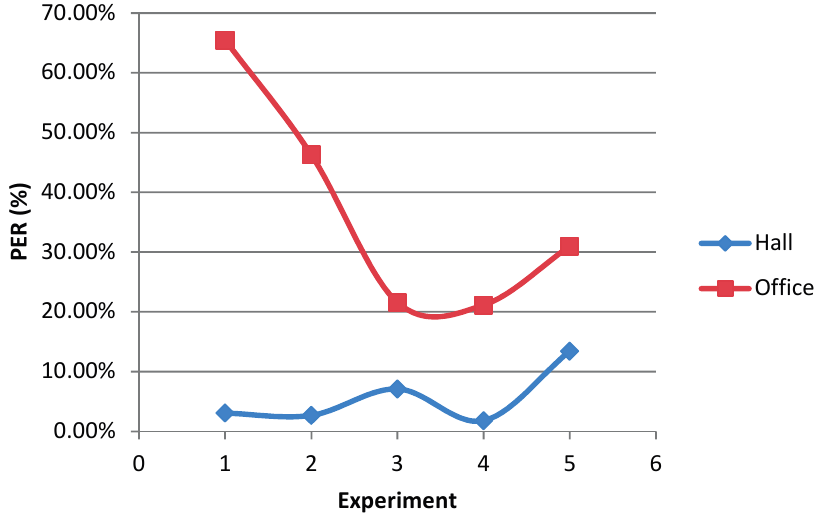
Figure 17. Packet error rate (PER) comparison between the hall and office base